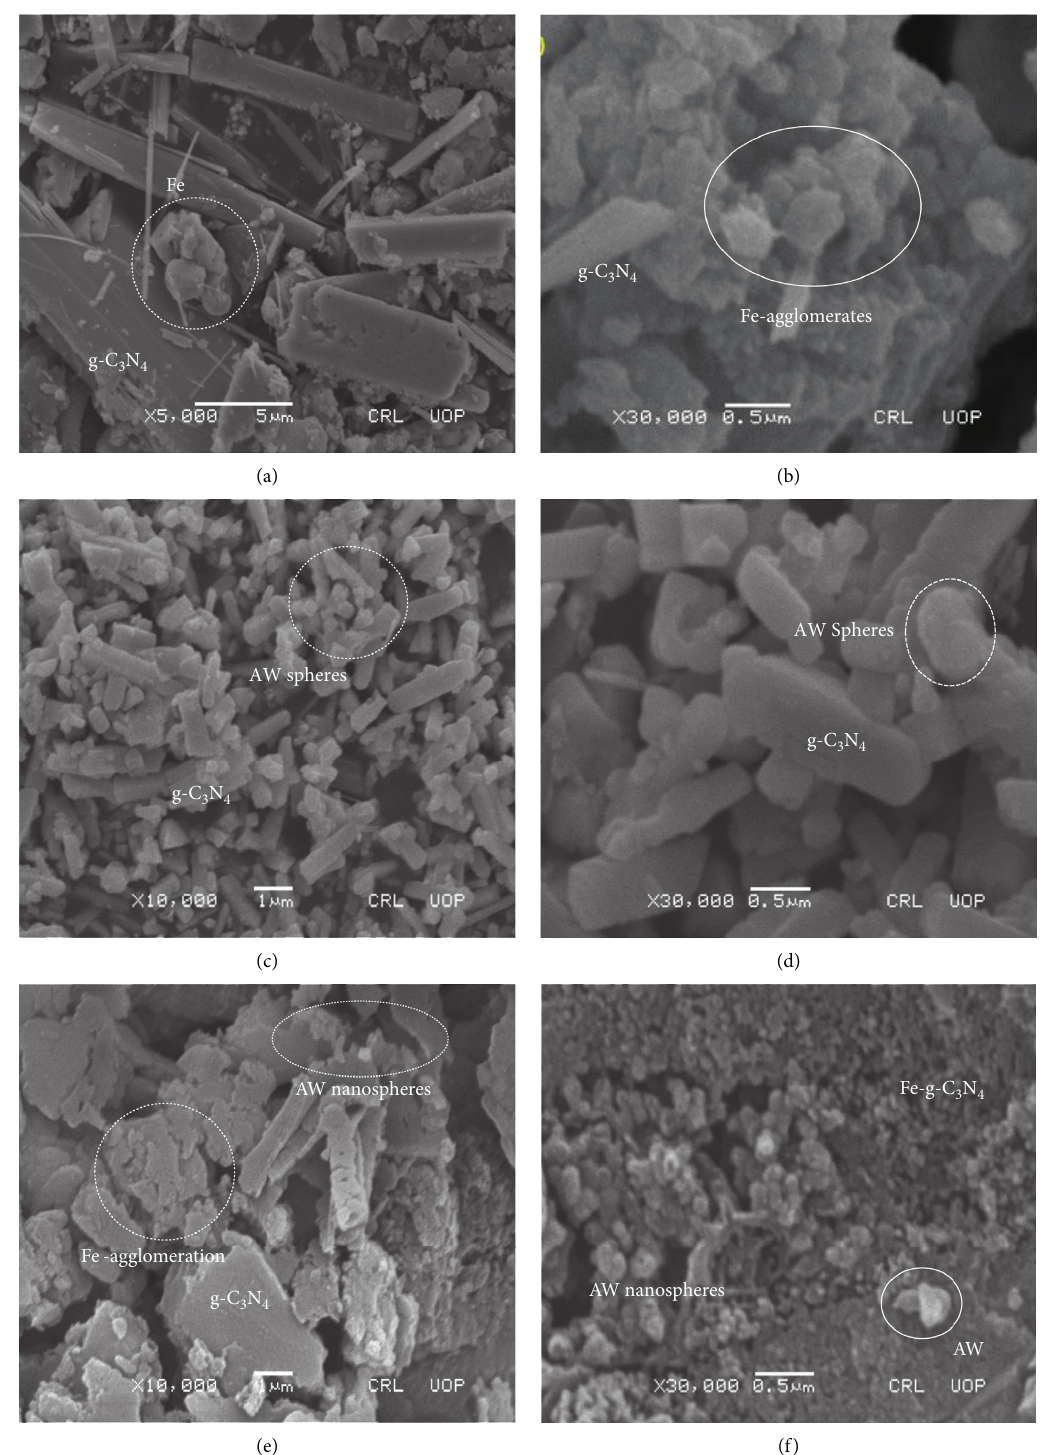
Figure 4: SEM analysis of (a and b) Fe-CN, (c and d) CN-AW, and (e and f) studies reveal that iron doping has strengthened the light In this equation, energy ( E ) � h ] , at ( α h ] � 0), where absorption response of the ternary photocatalyst in the ( α h ] ) 2 is plotted versus energy (eV). At h ] value, energy is visible region. The estimated band gap energies were calculated and then extrapolated to α � 0. The light fre- 2.56 eV, 2.8 eV, and 3.3 eV for Fe-CN/AW, Fe-CN, and quency, absorption coefficient, and proportionality con- CN-AW, respectively. The presence of g-C stant are explained by ( α , B, and ] ), respectively. The N as support 3 4